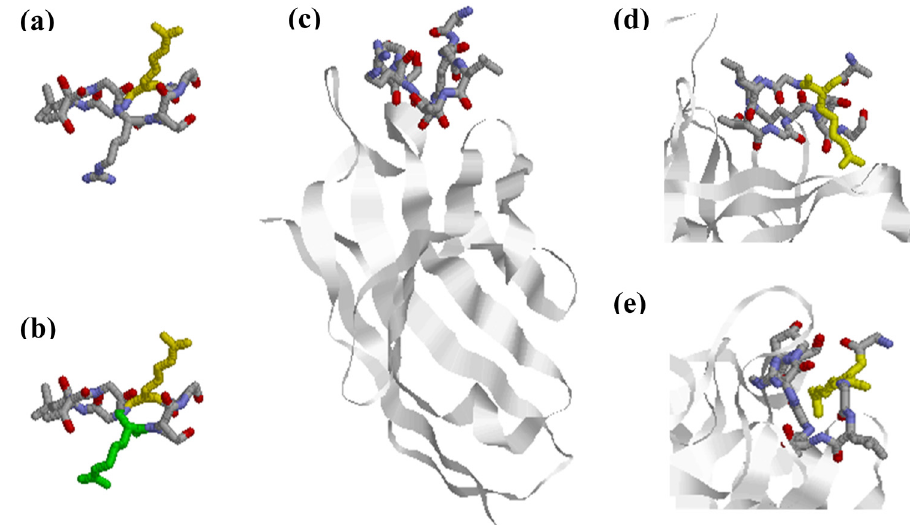
Figure 3. Anti-citrullinated collagen type II antibody in complex with citrullinated collagen II peptide aa 359–369. ( a ) Location of Cit (yellow) in the selected epitope; ( b ) Location of Cit (yellow) and Arg (green) extending in opposite directions; ( c ) Location of the citrullinated epitope in relation to the antigen-binding site of the antibody; ( d ) Location of Cit in the collagen II peptide relative to the antibody-binding groove; ( e ) Orientation of Cit into the antibody-binding groove. PDB ID: 2W65 [44].